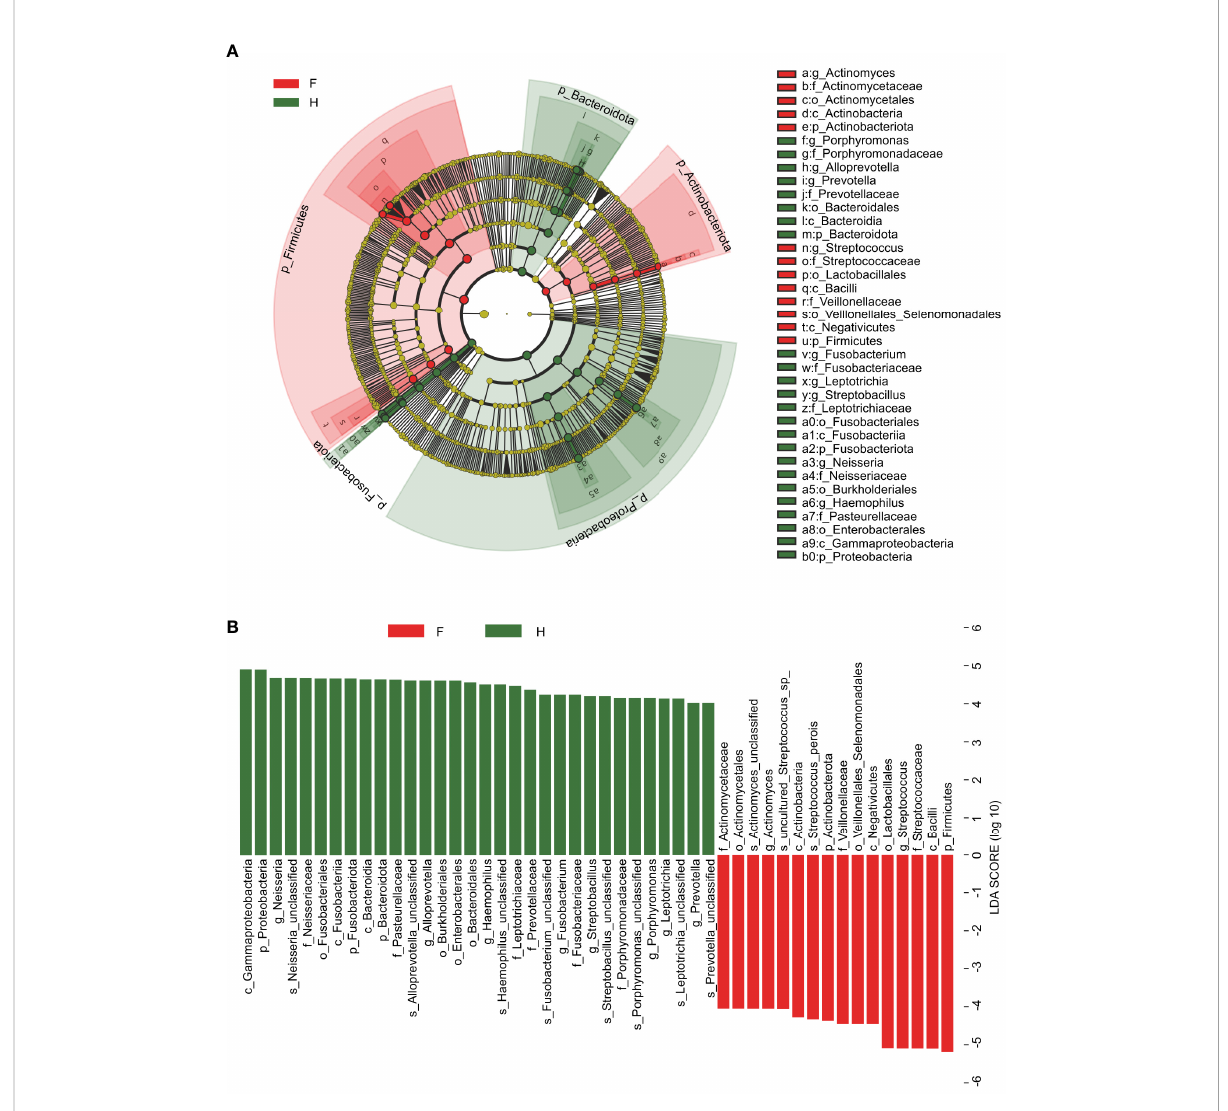
FIGURE 3 Linear discriminant analysis (LDA) and LDA effect size. (A) The cladogram visually indicates the differential species in each level in each group. F, IAV for abstract pneumonia group (red); H, healthy group (green). (B) Histogram of LDA scores for different abundant genera between groups H and (F) Red, enriched in the F group; Green, enriched in the H group. F, IAV pneumonia group; H, healthy group; IAV, in fl uenza A